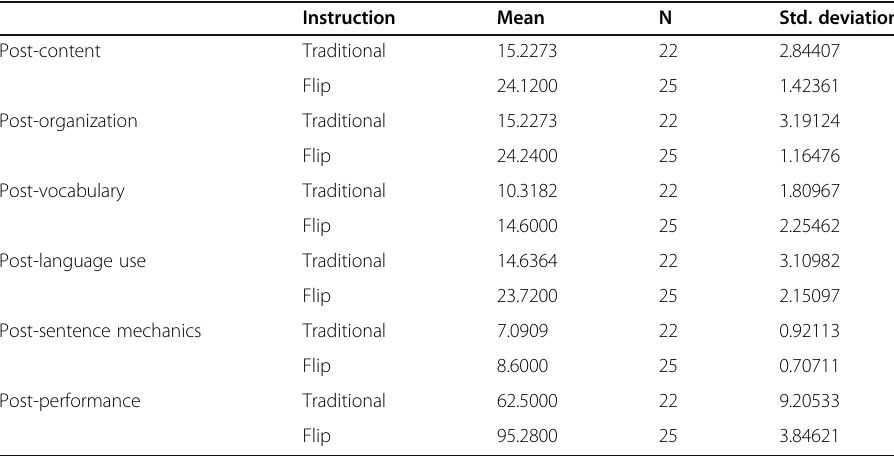
Table 3 Descriptive statistics for the differences between posttest mean scores of flipped and traditional groups Instruction